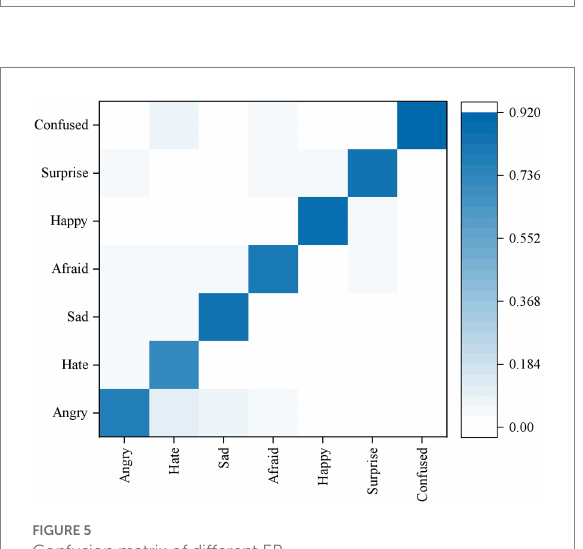
FIGURE 5 Confusion matrix of different